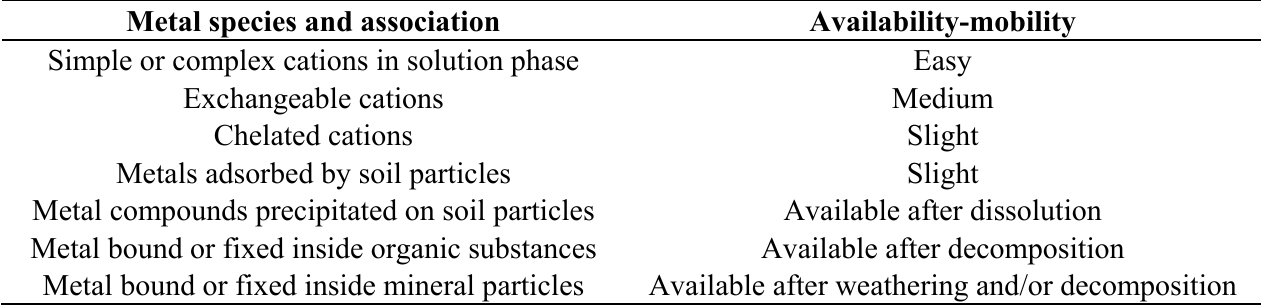
Table 3. Relative mobility and phytoavailability of metals species in